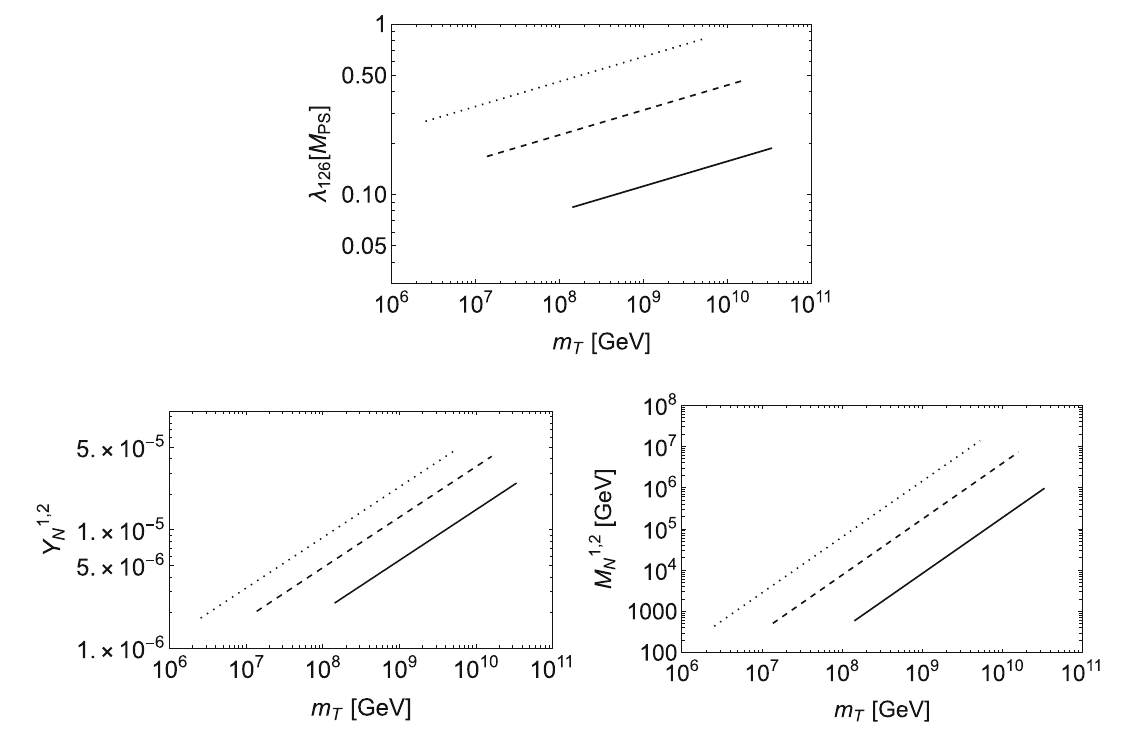
Fig. 6 For M PS = f a and fixed m D = 2 TeV, we show the plots for λ 126 , Y 1 , 2 and m 1 , 2 as a function of m T . The solid, dashed, N N and dotted lines correspond to m 126 / m T = 1 , 15 , 100, respec-